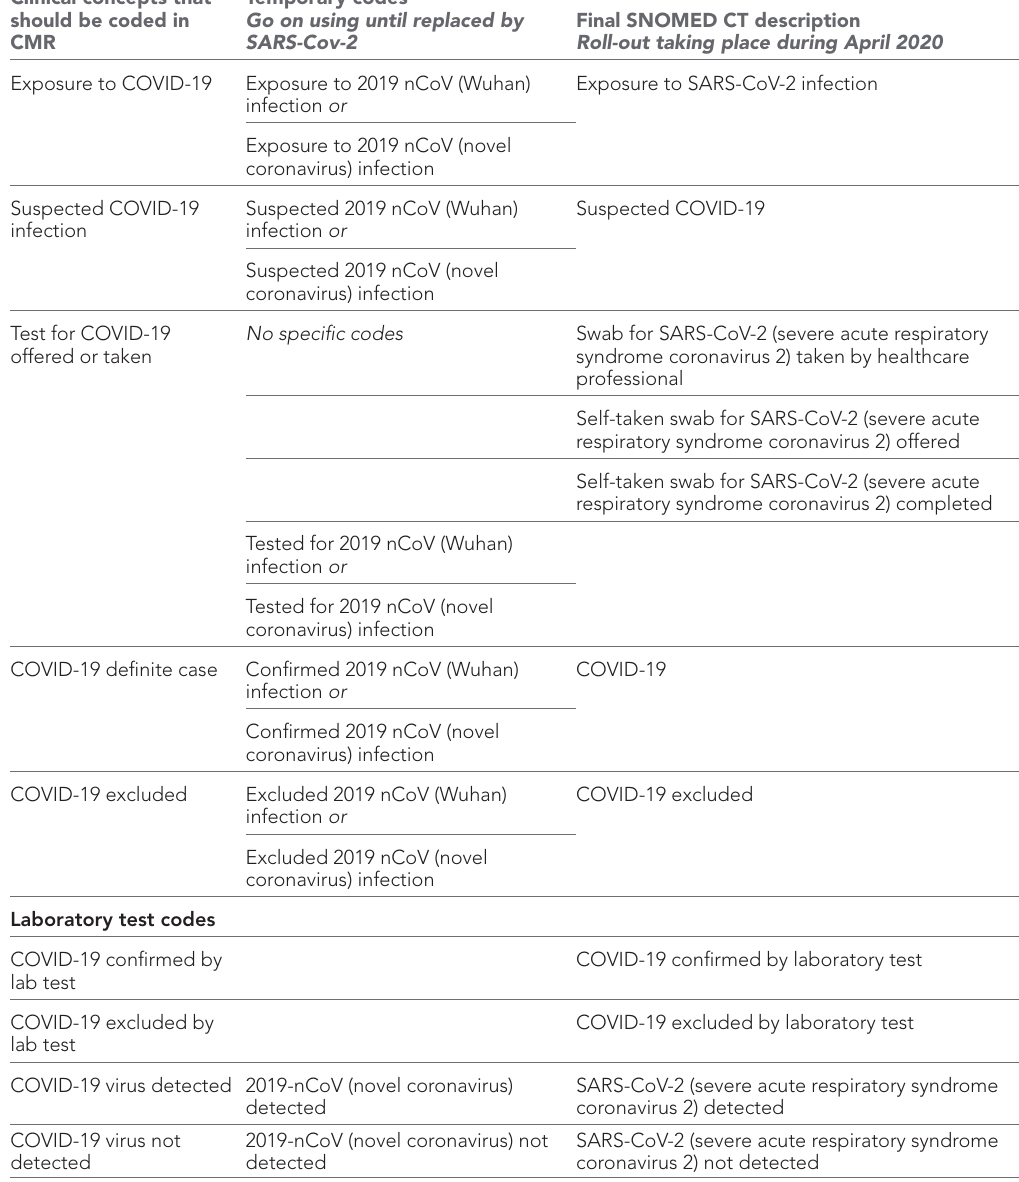
Table 1 Clinical concepts that should be coded, temporary and definitive codes Clinical concepts that should be coded